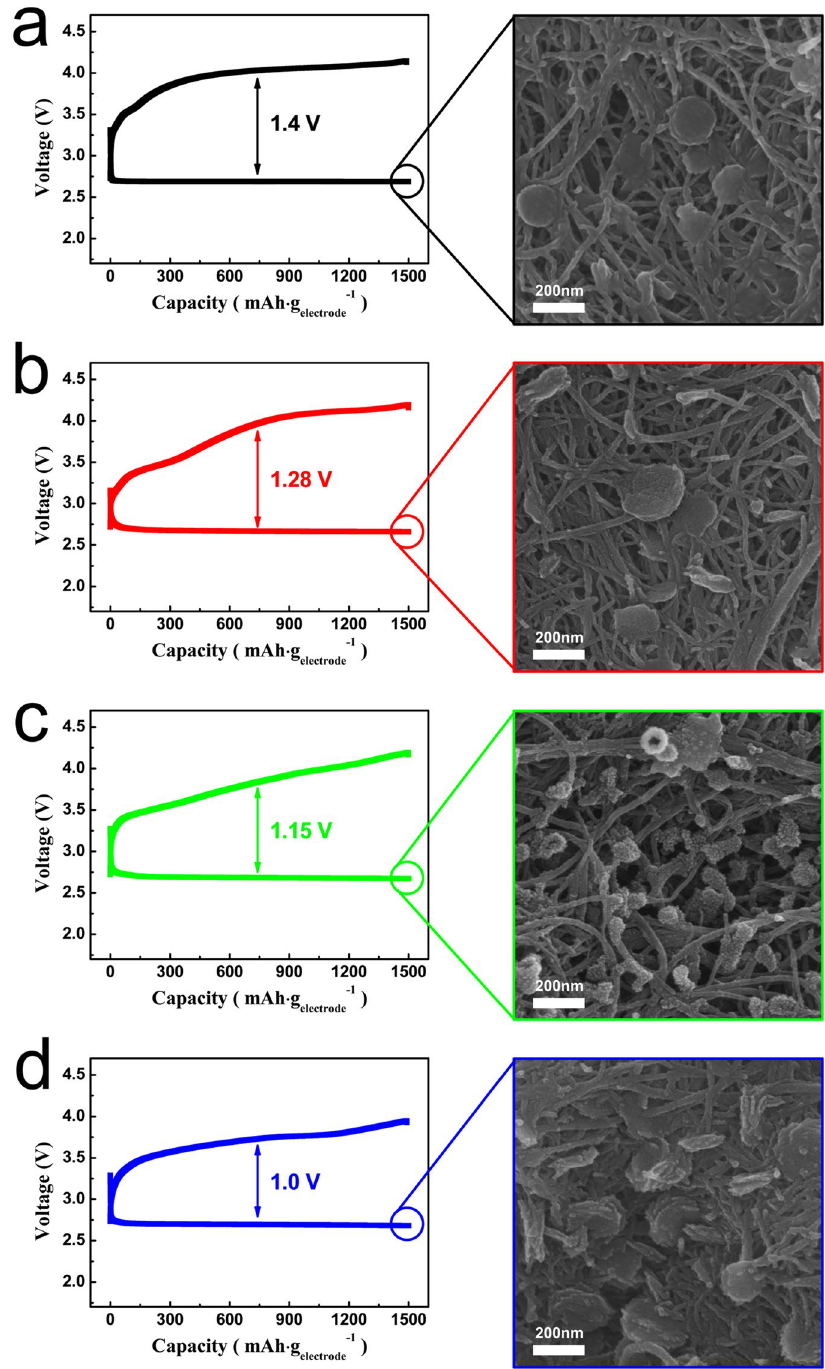
Figure 3. Initial discharge-charge profiles of the electrodes (left column) and SEM images of the surface morphologies of the discharged electrodes (right column). ( a ) The pristine electrode, ( b ) the PANI electrode, ( c ) the comp electrode, and ( d ) the PANI-comp